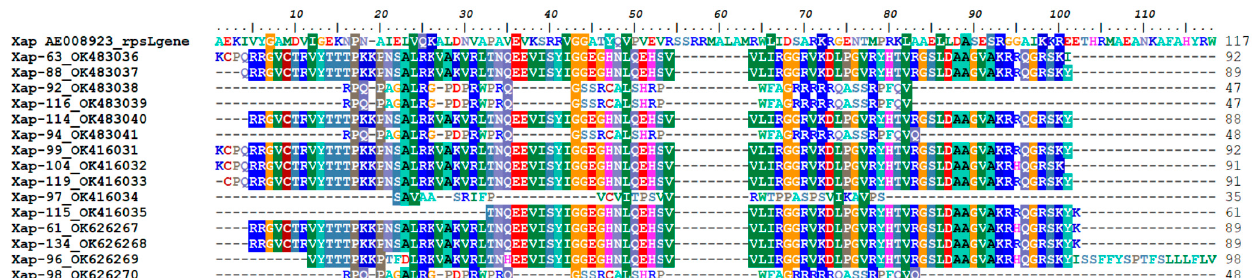
Figure 5. Multiple sequence alignment of rpsL nucleotide fragment amplified from Xap isolates and the reference sequence retrieved from NCBI database.